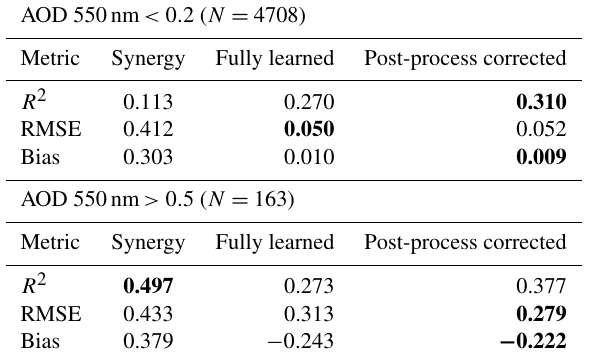
Table 1. Error metrics for the satellite data product AOD at 550nm corresponding to small ( < 0 . 2) and large ( > 0 . 5) AERONET AOD. The bold font indicates the best performing